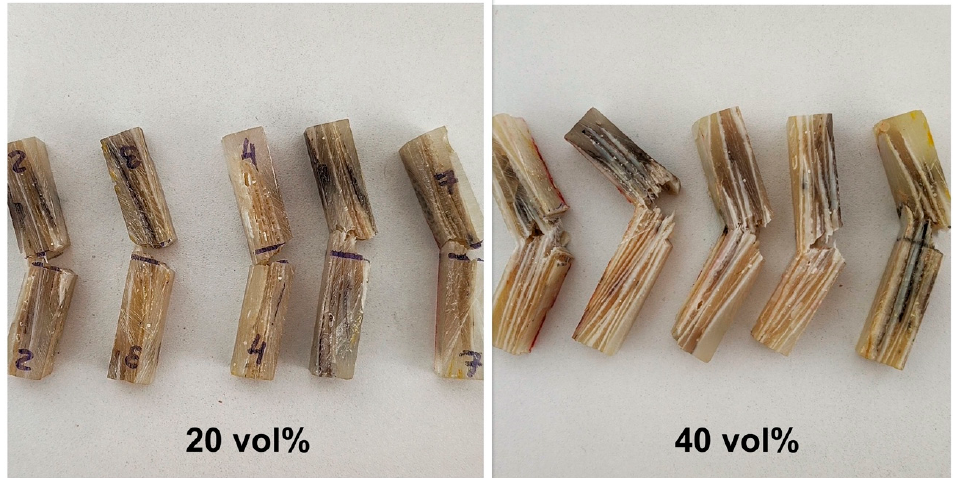
Figure 7. Fractured specimens after Izod impact test.